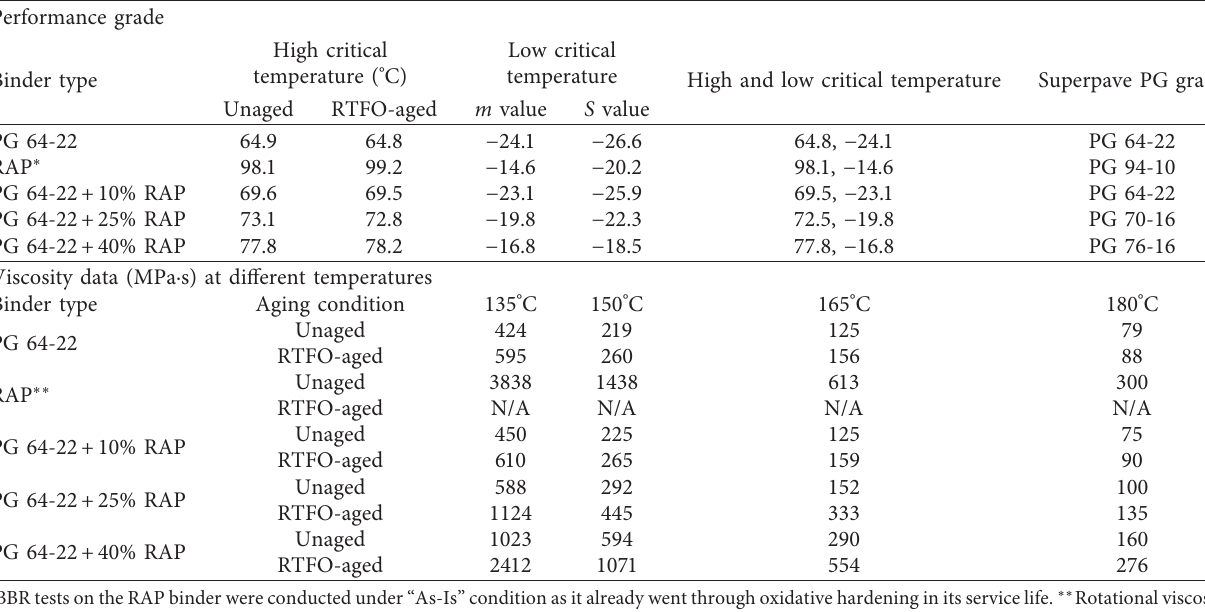
Table 2: Performance grade and viscosity of blended